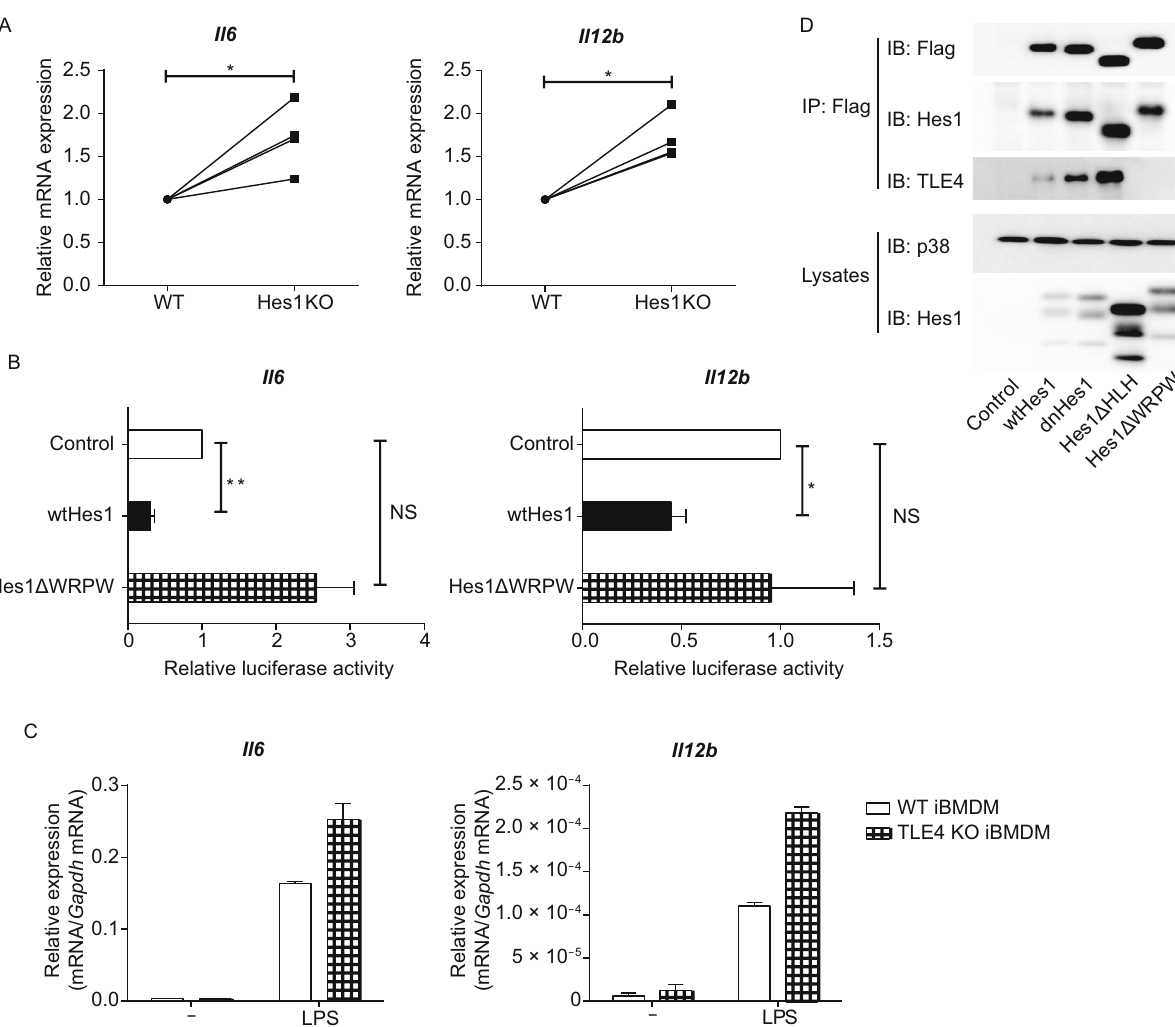
Figure 1. TLE4 is required for Hes1-mediated suppression of key pro-in fl ammatory gene expression . (A) Quantitative real- time PCR (qPCR) analysis of Il6 and Il12b mRNA in Mx1 -Cre (WT) and Hes1 fl / fl Mx1 -Cre (Hes1 KO) BMDMs stimulated with 10 ng/mL of LPS for 3 h, presented relative to that in WT BMDMs. (B) Luciferase activities in RAW264.7 cells co-transfected with Il6 or Il12b promoter-driven reporter constructs and a Hes1 expression plasmid (pMx-Hes1, wtHes1), a Hes1 mutant expression plasmid (pMx- Hes1 Δ WRPW, Hes1 Δ WPRW) or control vector (pMx-GFP). 24 h post infection, cells were left untreated or stimulated with 100 ng/mL of LPS for 6 h, and cell lysates were analyzed for luciferase activities. Results are presented as ratio of luciferase activity/total protein concentration, and are normalized to values in the control vector group. (C) Quantitative real-time PCR analysis of Il6 and Il12b mRNA in wild type (WT) and TLE4 KO iBMDMs stimulated with or without LPS (100 ng/mL) for 3 h. (D) Immunoblot analysis of indicated proteins in immunoprecipitated (IP) samples and whole lysates of HEK 293T cells that overexpressed wild-type Hes1 or Hes1 mutants. p38 was used as a loading control. Data are representative of three (C) independent experiments (mean ± s.d. of technical triplicates), or are pooled from four (A) or three (B) independent experiments (mean ± s.d. of biological triplicates). ns, not signi fi cant. * P < 0.05, ** P < 0.01 (Student ’ s paired t